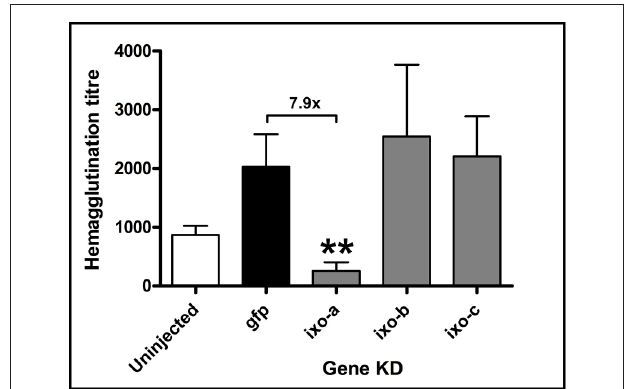
FIGURE 3 | Silencing of ixoderin a abolishes lectin activity of the tick hemolymph. The effect of injection (wounding) and ixoderin KDs on the haemagglutination activity of semi-engorged tick hemolymph was measured using 2% mouse RBC. The hemagglutination titer was calculated as hemagglutination activity per 1 µ l of tick hemolymph. Hemagglutination titer in the dsGFP group served as an injection control. Two asterisks indicate p -value <